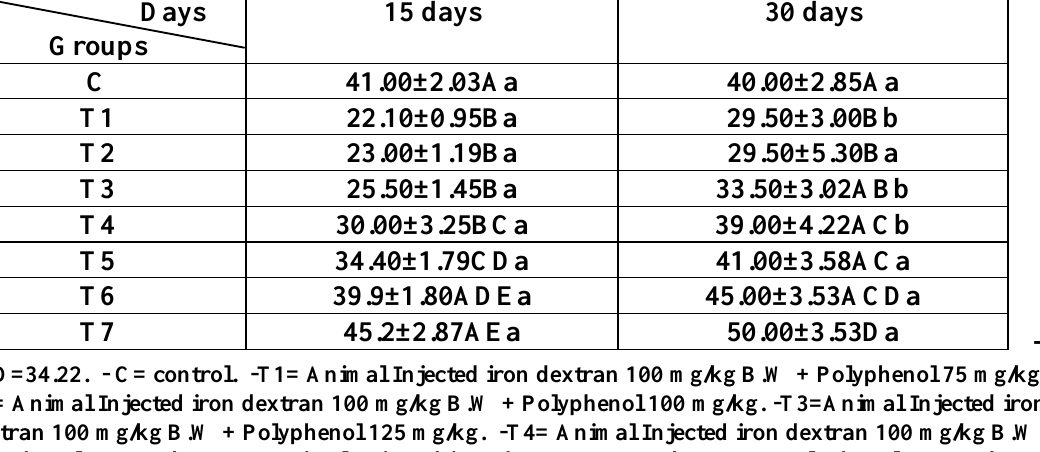
Table 4: Effect of different doses of total polyphenol extracted from Green tea on Serum Catalase Activity (kU/l) of iron overload treated rats.